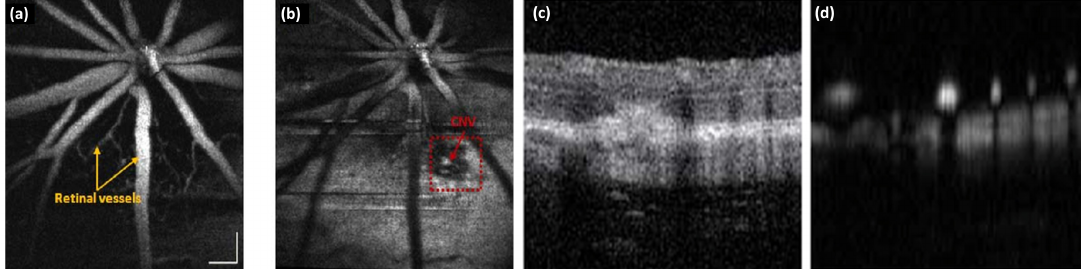
Figure 8. PAOM of choroidal neovascularization in mice. ( a ) Two-dimensional (2D) enface image of anterior retinal structure. ( b ) PAM image of the laser-induced CNV regions. Red arrows point to the CNV region. ( c ) and ( d ) are OCT B-Scan and PAM B-Scan, respectively. CNV: choroidal neovascularization Bar: 100 µm. Reproduced with permission from ref. [86]